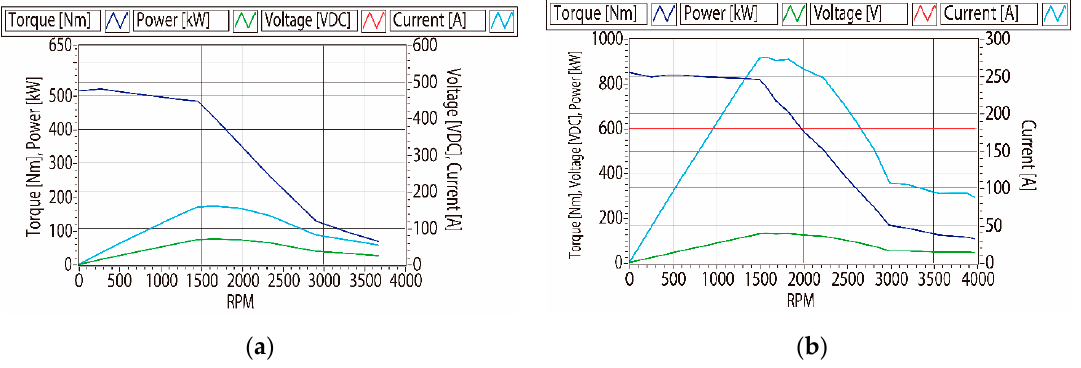
Figure 17. Electric motor curves: ( a ) continuous graph; ( b ) peak graph.